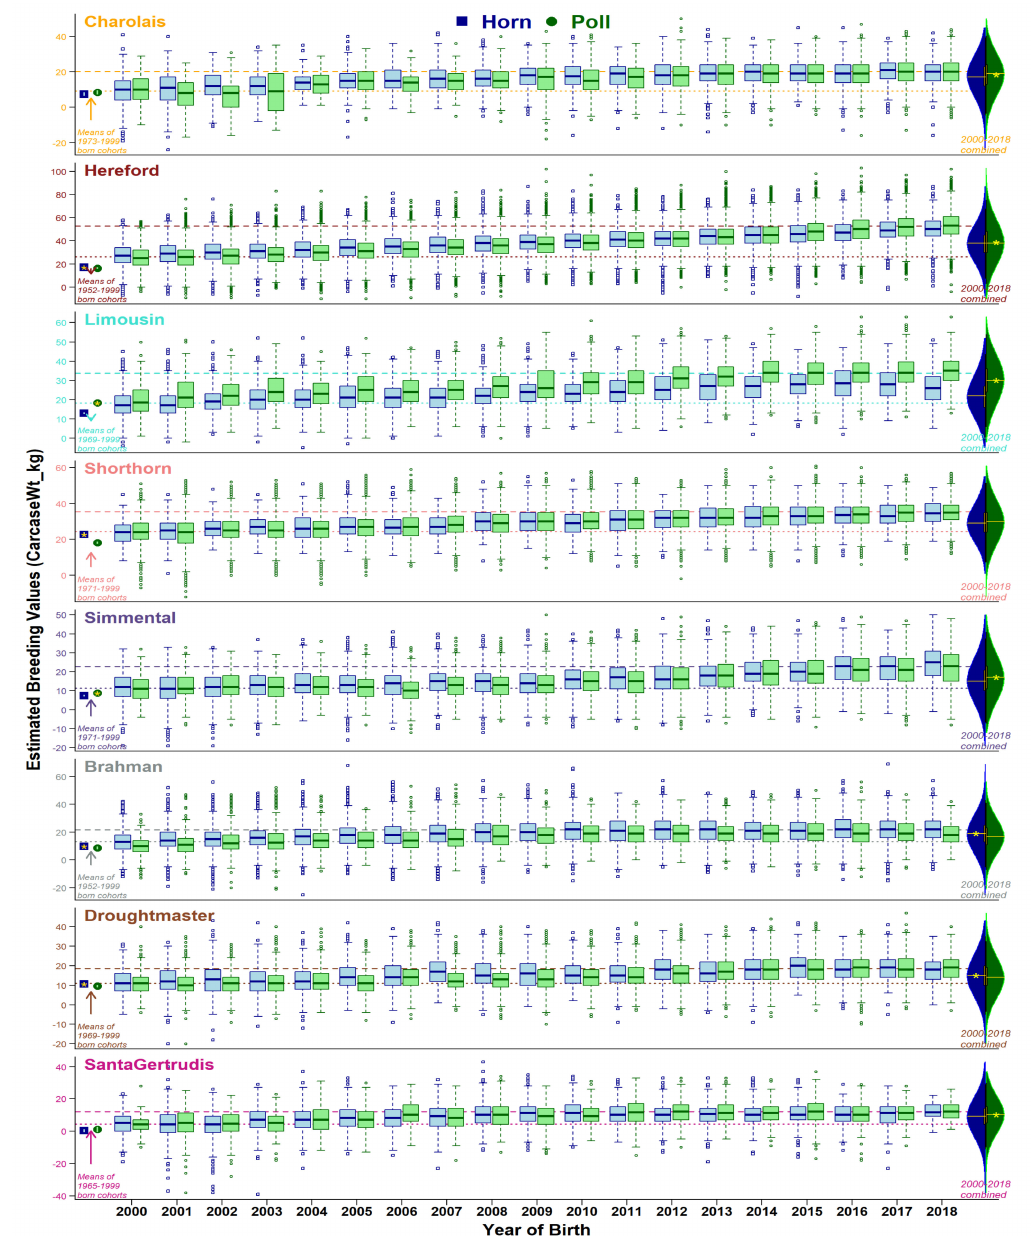
Figure 4. Boxplots of carcass weight EBVs (accuracy ≥ 50%) for horn (blue) and poll (green) cohorts born from 2000 to 2018. Dotted and dashed lines show breed averages at the start (2000) and end (2018) of the selected period. Points at the left side of graphs show cohort averages for recorded animals born before 2000. On the right side, violin plots show the distribution of horn and poll cohorts during 2000 to 2018 combined, with a yellow star representing a statistical significance of mean